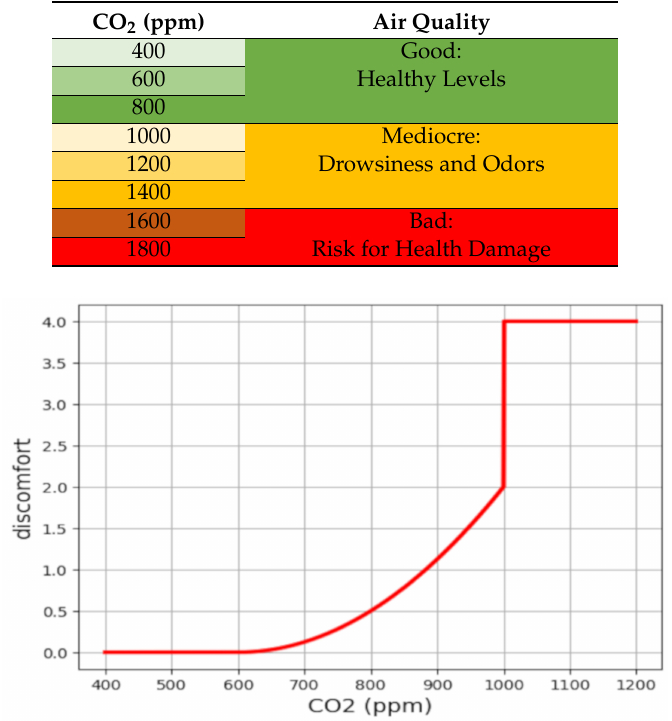
Table 2. CO 2 levels e ff ects on health.